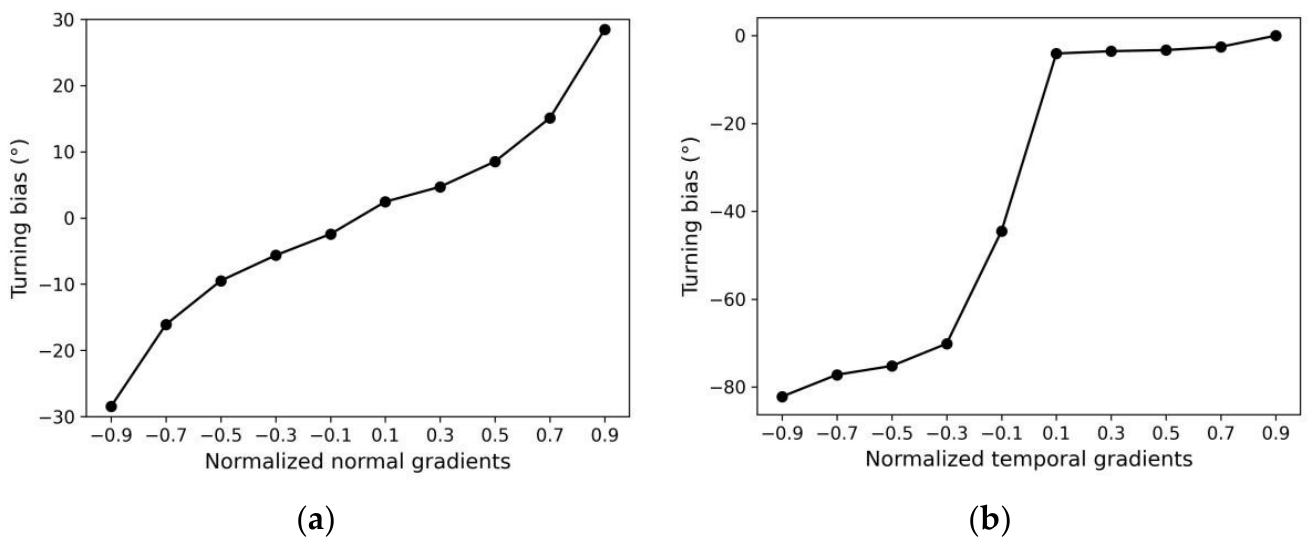
Figure 14. Quantitative analysis of search behavior strategies: ( a ) turning bias vs. Normal concen- tration gradient of klinotaxis trajectories; and ( b ) turning bias vs. temporal gradient of klinokinesis trajectories. All gradients were linearly normalized to between -1 and 1.